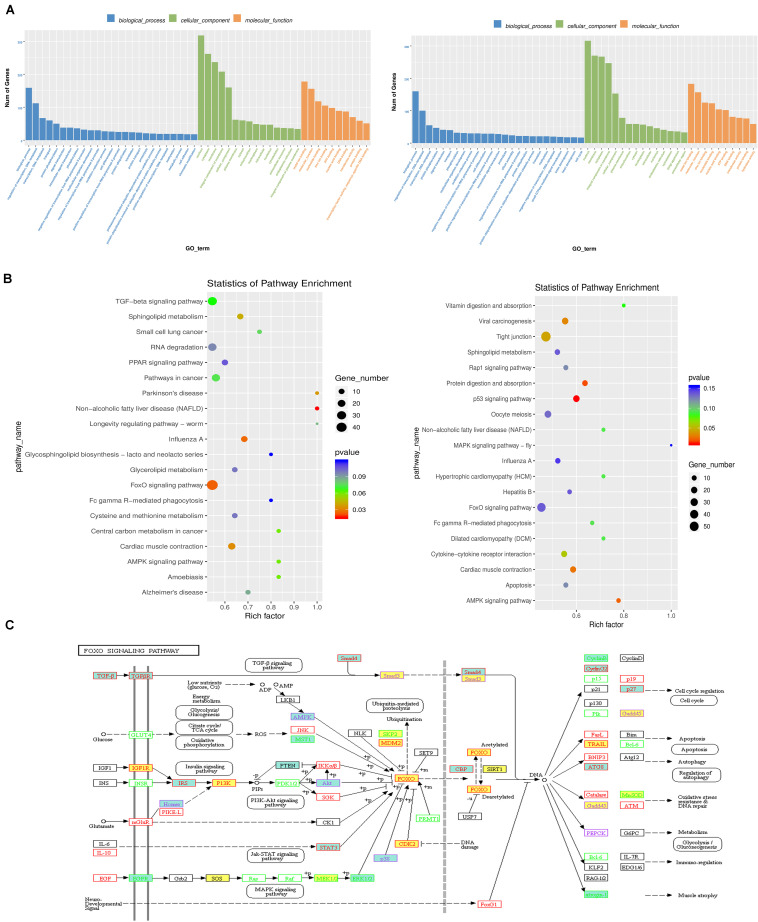
The regulatory role of the differential RNA methylation of genes showing differential expression between the flounder ovary and testis. (A) Gene ontology term (GO) assignment classes of DEGs (left, WF vs. WM; right, GF vs. GM). (B) KEGG pathway classifications of differentially expressed genes (left, WF vs. WM; right, GF vs. GM). (C) FoxO signaling pathway. Yellow background indicates m6A upregulated genes in the flounder ovary. Green background indicates m6A downregulated genes in the flounder ovary.